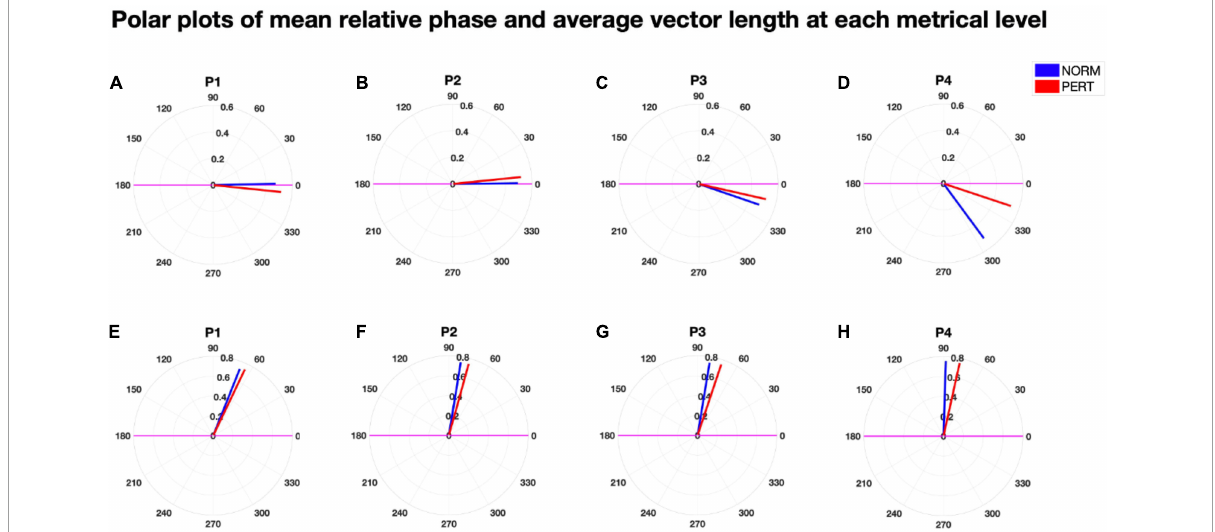
FIGURE7 Polar plots of the (signed) mean relative phase (A–D) and the mean absolute relative phase (E–H) as well as their associated vector length, for each experimental condition and at each metrical timescale. The size of the vector length of the (signed) mean relative phase was higher in PERT than in NORM, and significantly so for P1 and P3. The (signed) mean relative phase was significantly shorter (i.e., closer to 0 ◦ , that is, synchrony) in PERT than in NORM for P4. The mean absolute relative phase was also shorter in PERT than in NORM for P2, P3, and P4. Overall, phase relationships were thus slightly but significantly more stable and closer to synchrony at several metrical timescales in PERT than in NORM.